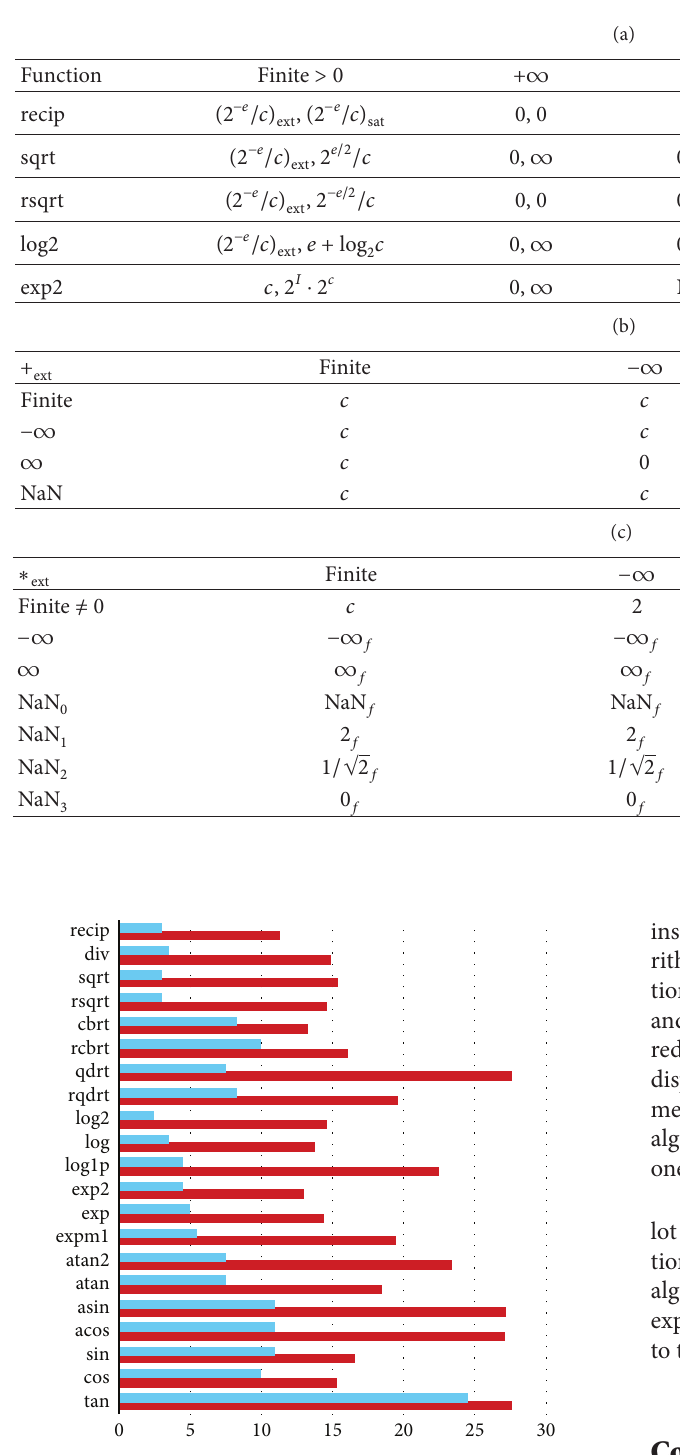
Table 2: (a) Values returned by lookup instructions, for IEEE floating-point inputs (−1) 𝑠 2 𝑒 𝑓 , which rounds to the nearest integer 𝐼 =